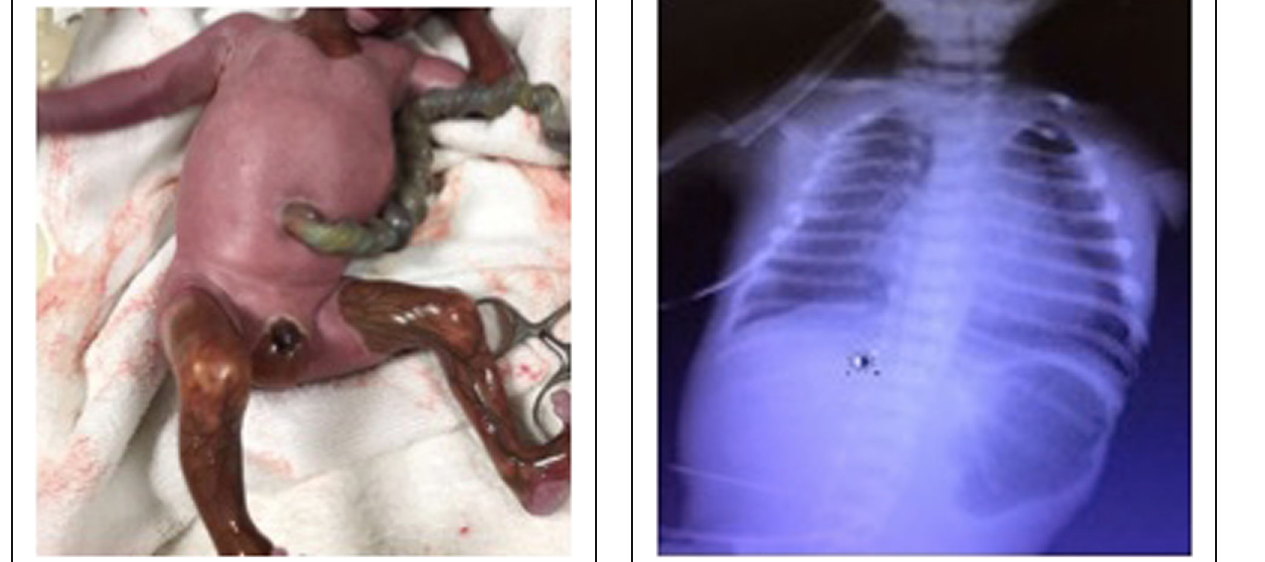
Fig. 1 Aplasia cutis from the left arm, legs, and scrotum of the patient